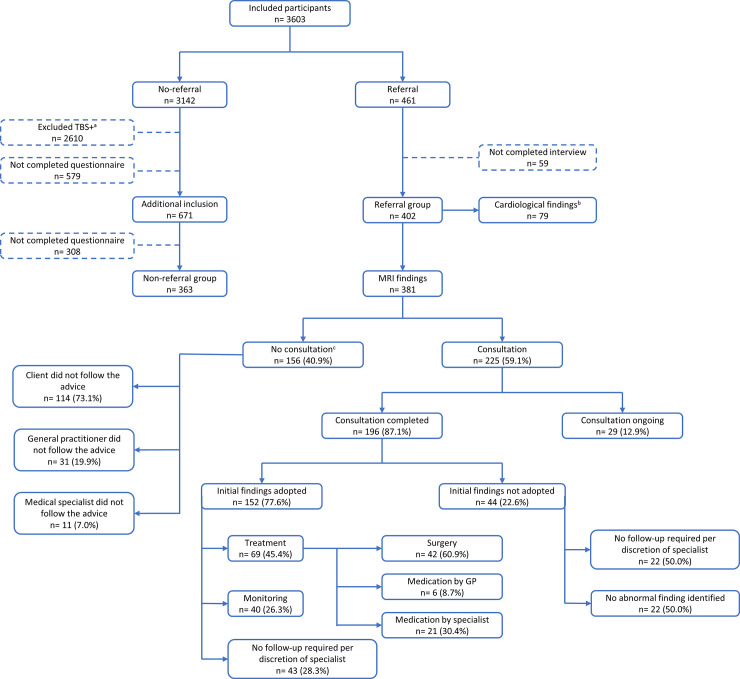
Flowchart of included participants, and overview of follow-up and management of MRI-findings in general healthcare the referral group.a A TBS+ (Total Body Scan +) is the standard MRI- and cardiovascular screening procedure with optional additional examinations, e.g.: laboratory tests, CT-scans, gastro- and colonoscopy’s or ultrasounds. These clients were excluded (n = 2610) from follow-up in the non-referral group, because of the possibility of (additional) findings with these examinations. b An overview of follow-up and management of cardiological findings can be found in S2 Fig. c
‘No consultation’ included clients who did not follow the advice for a consultation <3 months during the study period.